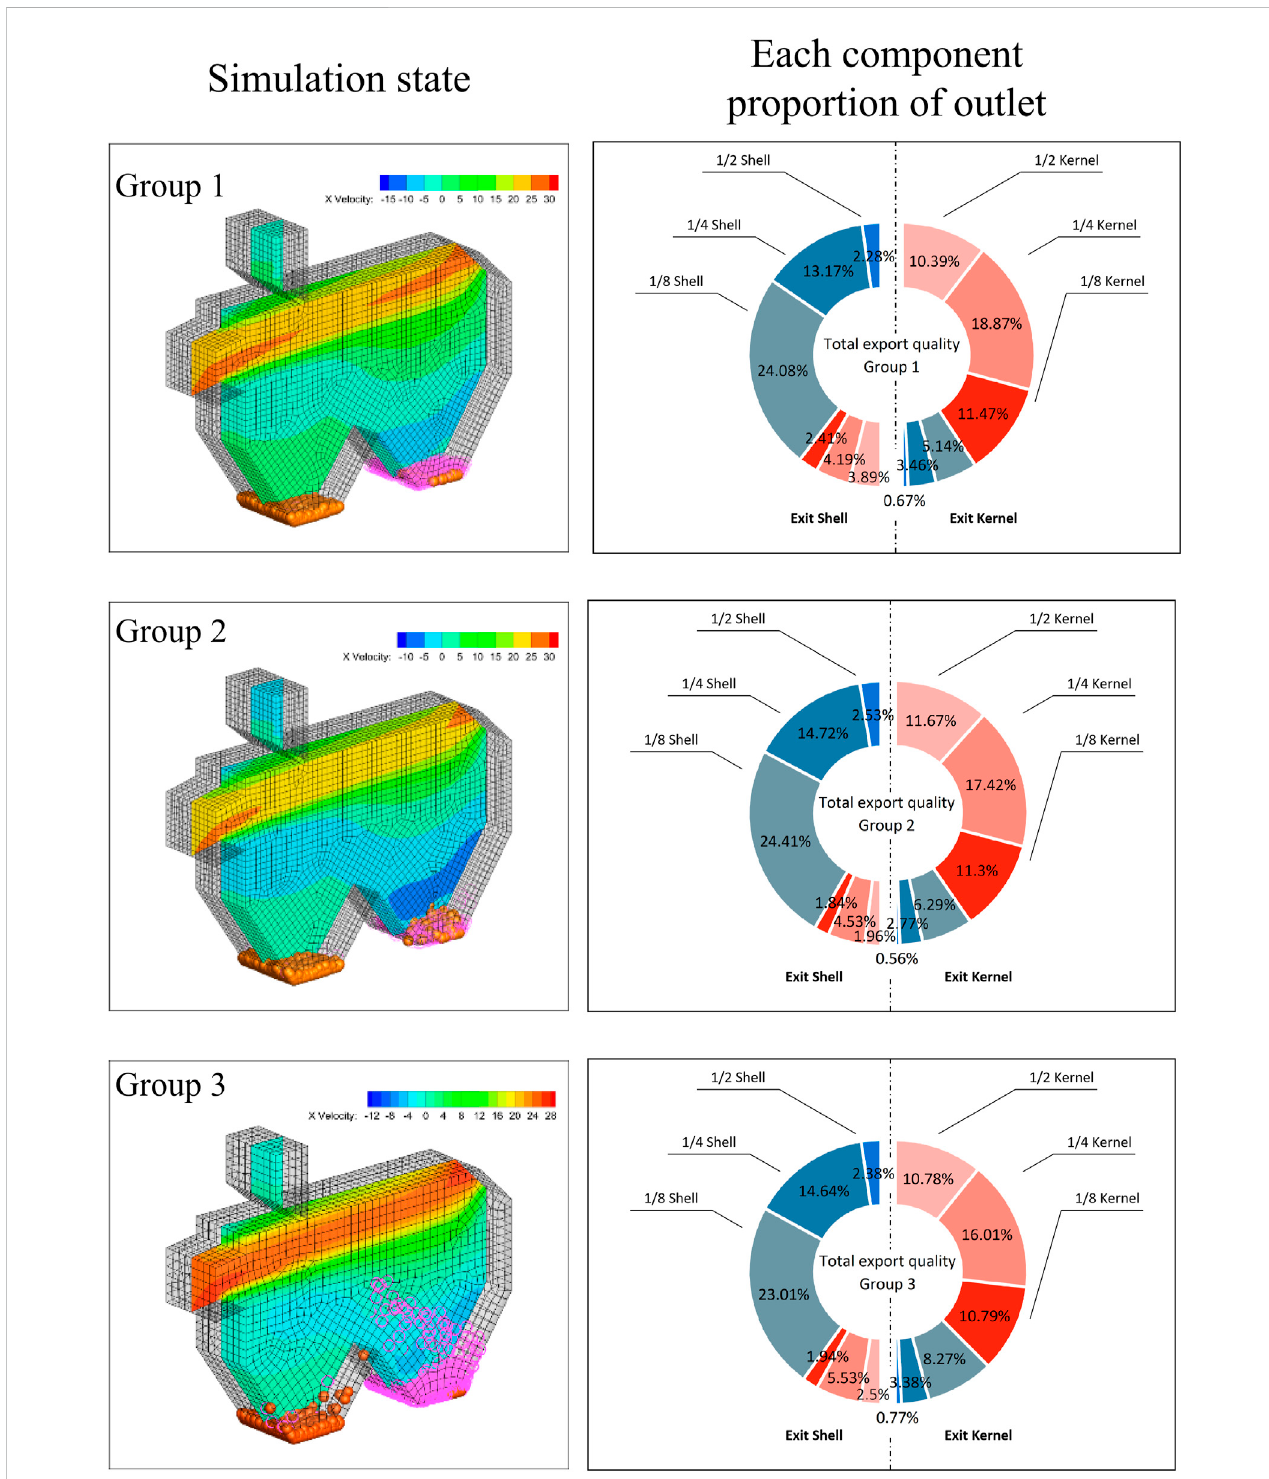
FIGURE 9 Simulation status and proportion